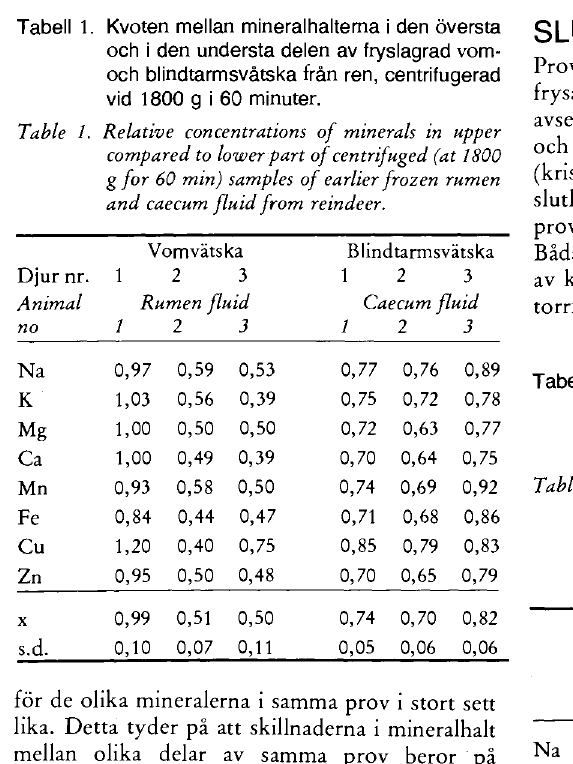
Tabell 1. Kvoten mellan mineralhalterna i den overstå och i den understå delen av fryslagrad vom-